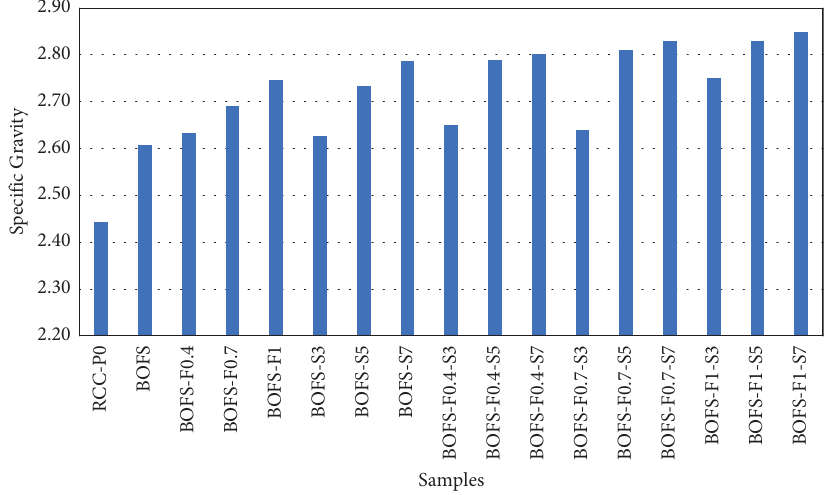
Figure 11: Specifc